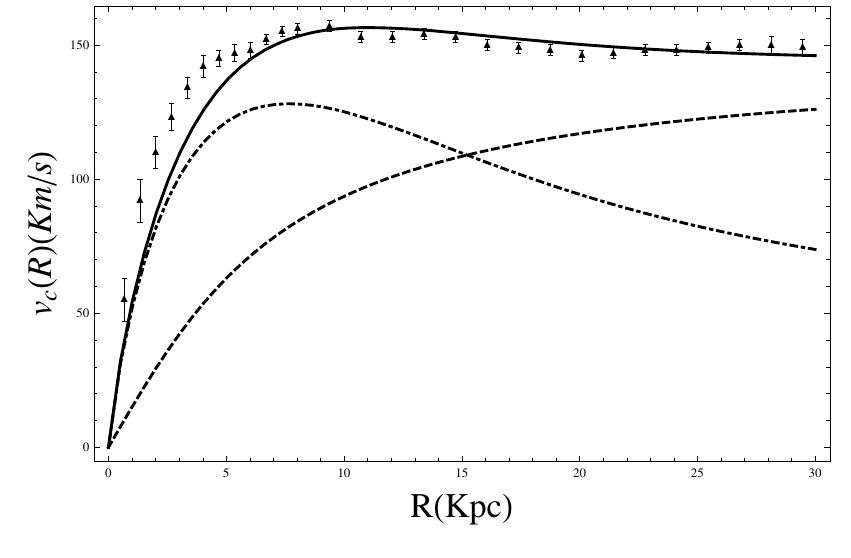
Figure 9. Superposition of theoretical behaviors (GR (dashed line), GR + DM (dashed and dotted line), FOG (solid line), FOG + DM (dotted line)) on the experimental data for NGC 3198. The mass model used is shown in Equation (88) and the values of parameters are in = 10 − 2 Kpc − 1 and µ = 10 2 Kpc − 1 Table 1. The values of “masses” are µ 1 2